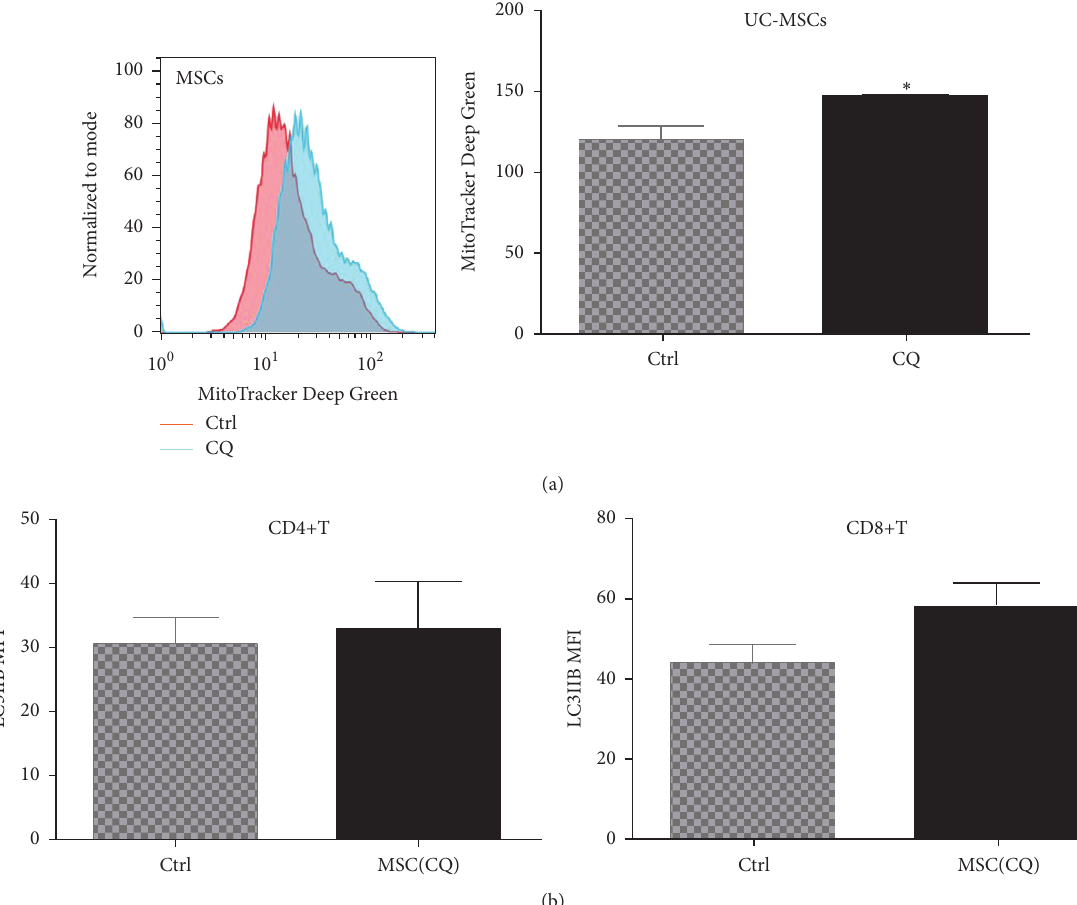
Figure 8: Functional mitochondria were essential for UC-MSCs to regulate T cell autophagy. UC-MSCs labeled with MG were treated with chloroquine (CQ, 50 𝜇 M for 24h) to block mitochondrial turnover. Then PBMCs were stimulated with anti-CD3/28 and cultured with CQ- treatedUC-MSCsfor3days.Allexperimentswereperformedintriplicate.(a)CQtreatmentcausedmitochondrialaccumulationinUC-MSCs ( 𝑛 = 4 ). (b) UC-MSCs with accumulated mitochondria lost the ability to regulate T cell autophagy ( 𝑛 = 4 ). ∗ 𝑝 < 0.05